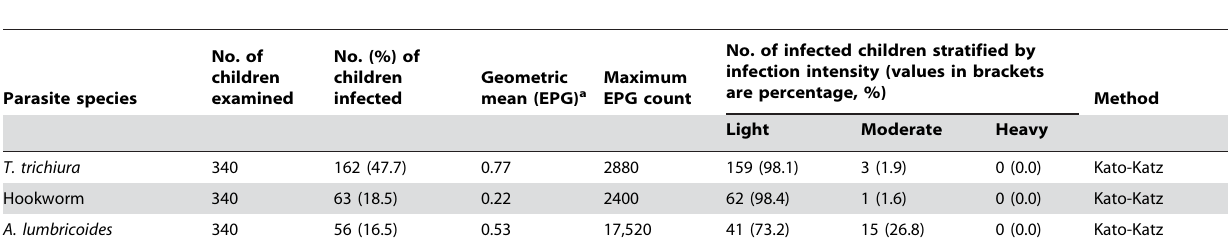
Table 1. Characteristics of soil-transmitted helminth infections among children from Chaani and Kinyasini schools, Zanzibar, as determined by the Kato-Katz technique.